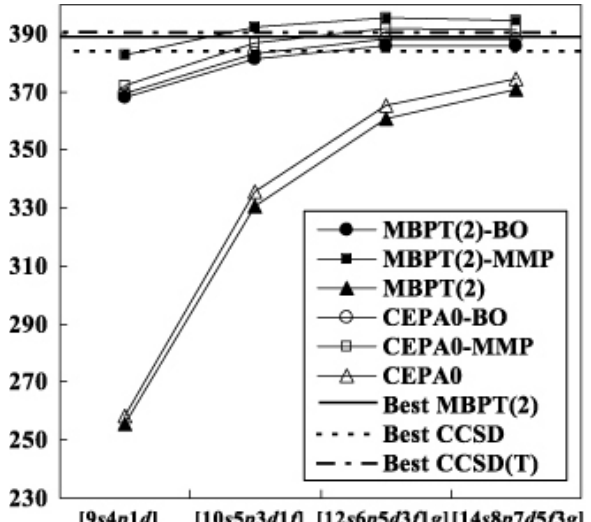
Figure 3. Convergence of the correlation energy of Ne. The notations are same as those in Figure 2. level, while the conventional method covers only 65.8% and 85.1% of the R12-MBPT(2)-A